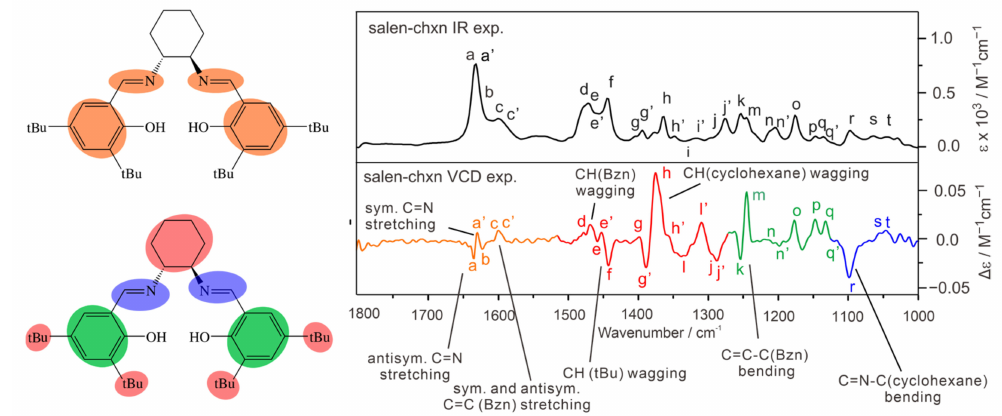
Figure 5. The general assignment of the IR and VCD bands of salen-chxn. The main IR and VCD band features are labelled “a” to “t” to aid the comparison as in Figure